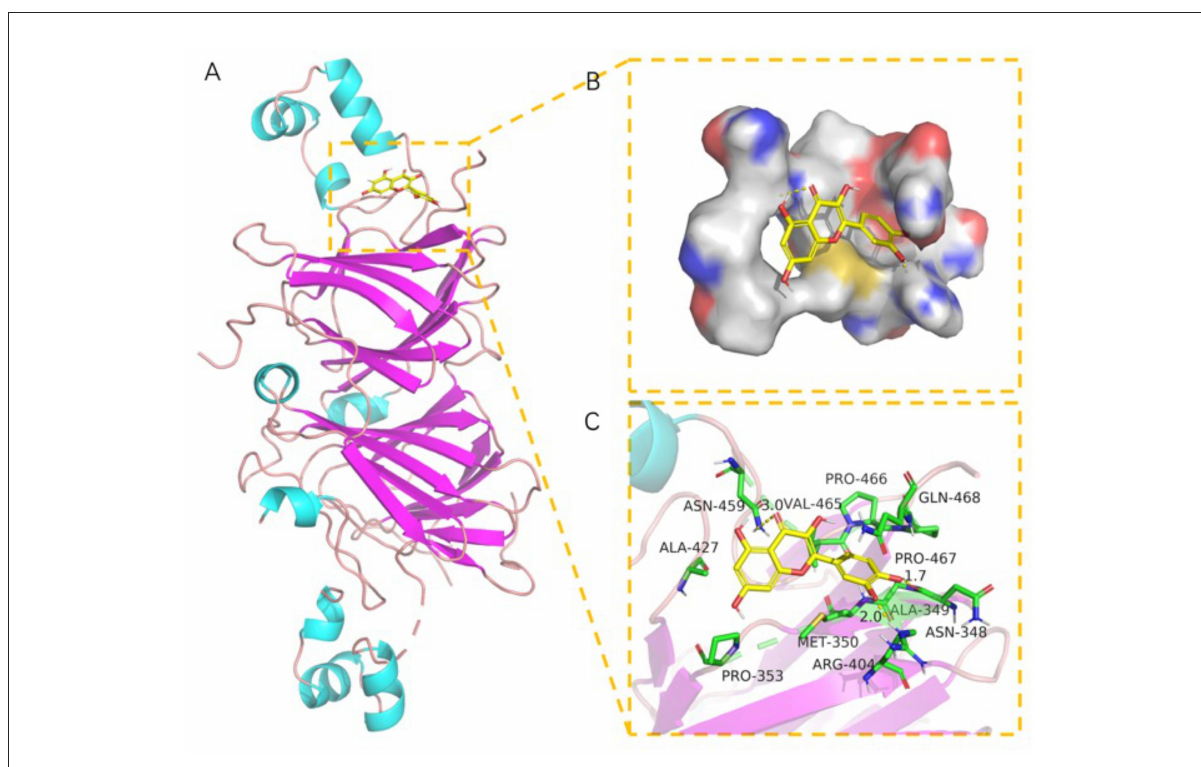
FIGURE6 The binding mode of 11S with quercetin: (A) The 3D structure of complex. (B) The surface of active site. (C) The detail binding mode of complex. The backbone of protein was rendered in tube and colored in bright blue. quercetin compound is rendering by